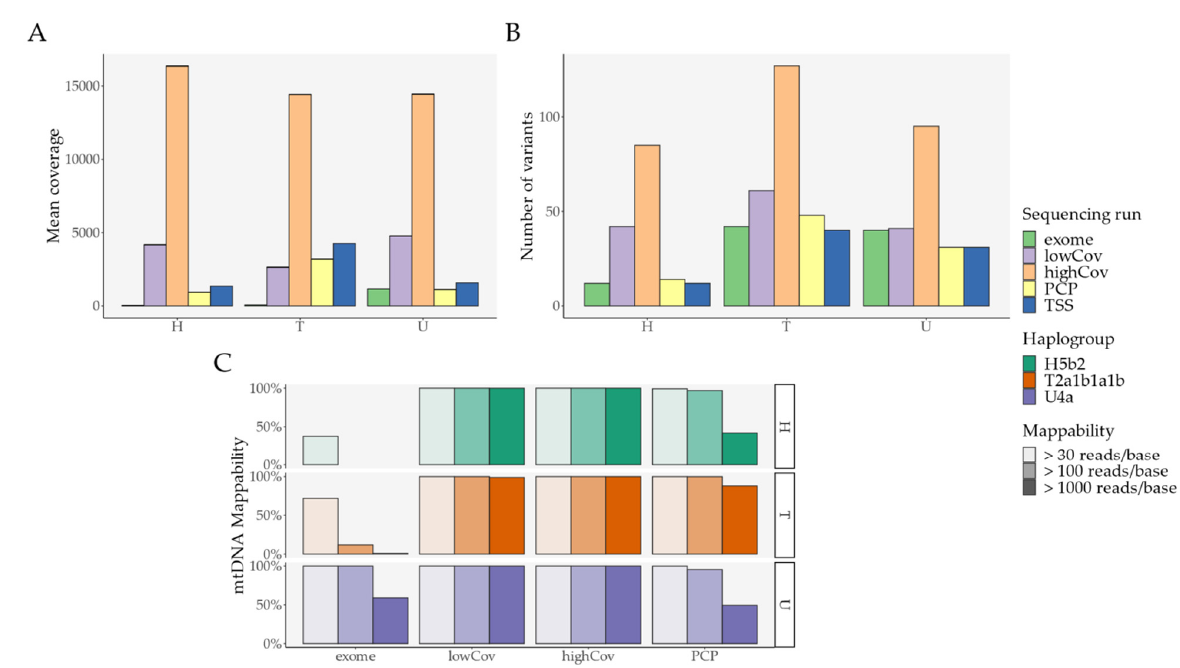
Figure 2. Primary analysis: Overall look; variant threshold was set at 0.4% for exome, lowCov, and highCov, and 2.5% for PCP. ( A ) Mean coverage per sample and per sequencing run/pipeline; ( B ) Number of variants per sequencing run/pipeline; ( C ) Mappability and haplogroup assignment per sequencing run/pipeline (TSS is not shown since it does not output raw data). Error bars denote standard error of the mean (SEM). Abbreviations: PCP—PrecisionCallerPipeline; TSS—Ion Torrent Suite™ Software.